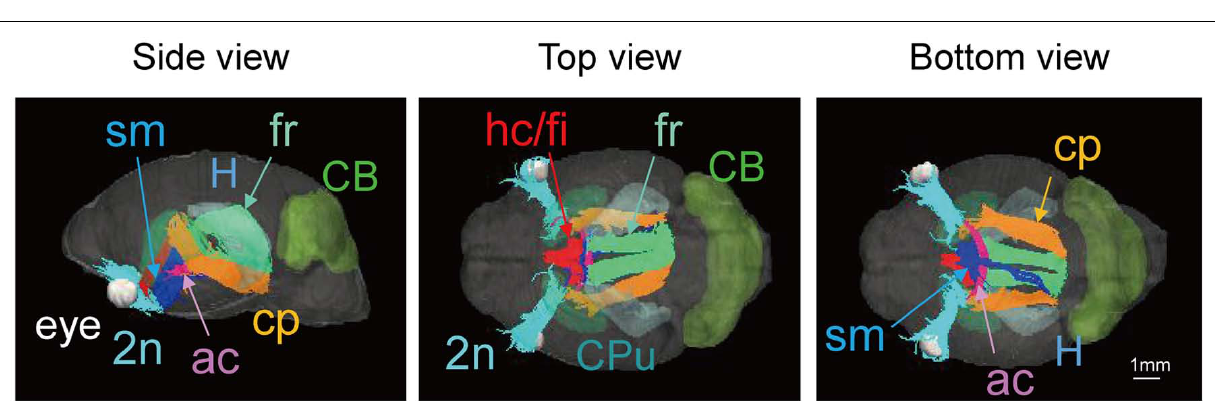
hc/fi,hippocamalcommissure/fimbria(red);sm,striamedularis(blue),together withthecaudateputamen(CPu,lightgreen),thecerebellum(CB,green),the hippocampus(H,lightblue),andtheeye(white).Scalebar = 1mm.